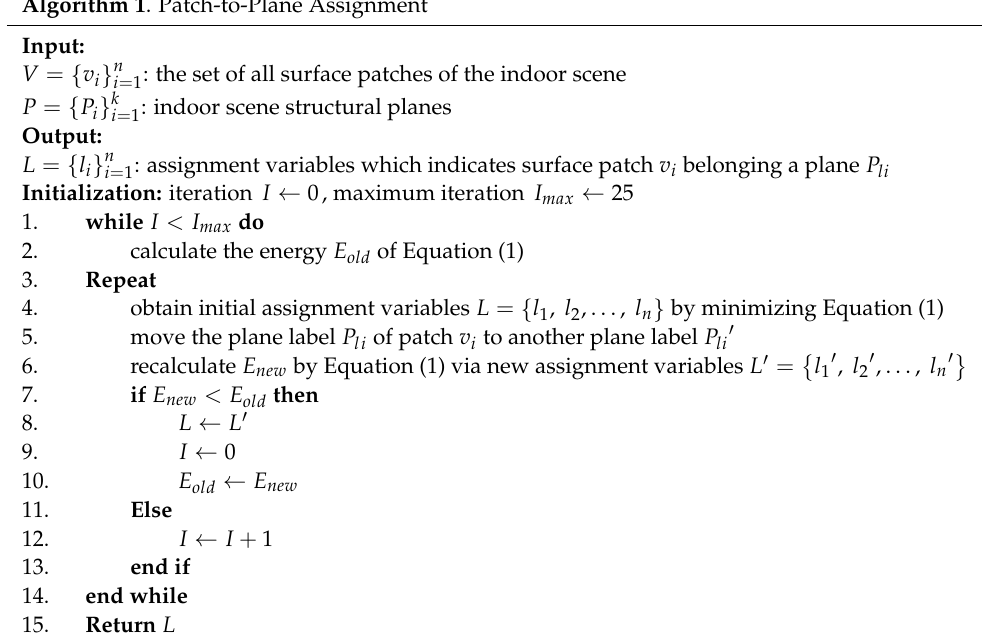
Algorithm 1 . Patch-to-Plane